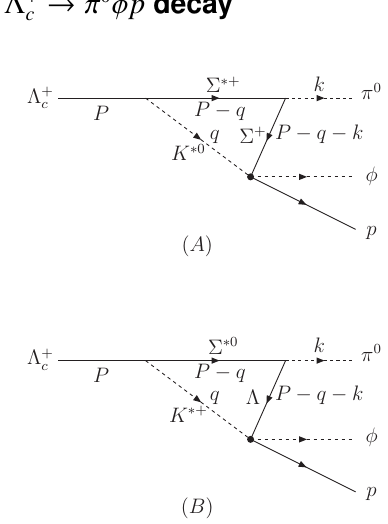
→ π 0 p φ decay. ( A ): Σ + - c